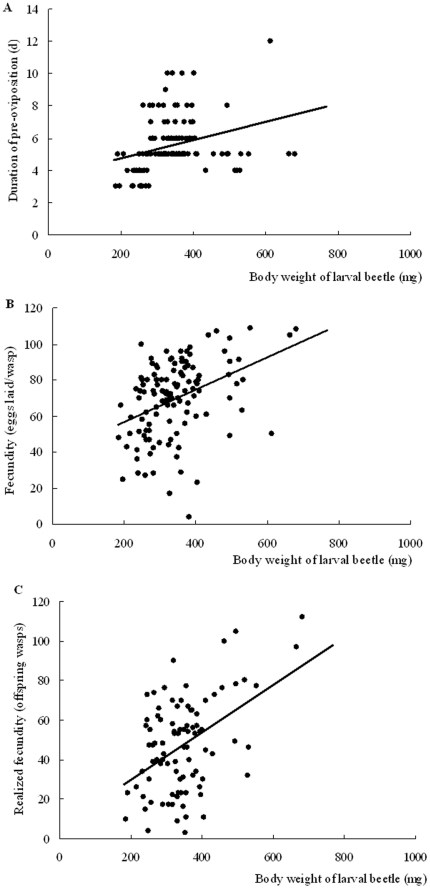
Correlation between Monochamus alternatus larvae size and Sclerodermus harmandi mother wasp fitness indices.Effect of host size is assessed separately for (A) duration of pre-oviposition (y = 0.0056×+3.6497, r2 = 0.0955, F1,129 = 13.623, p<0.0001), (B) egg laid (y = 0.0891×+39.075, r2 = 0.1529, F1,120 = 21.664, p<0.0001), and (C) offspring wasps emerged (y = 0.1203×+5.6948, r2 = 0.2142, F1,90 = 24.527, p<0.0001).